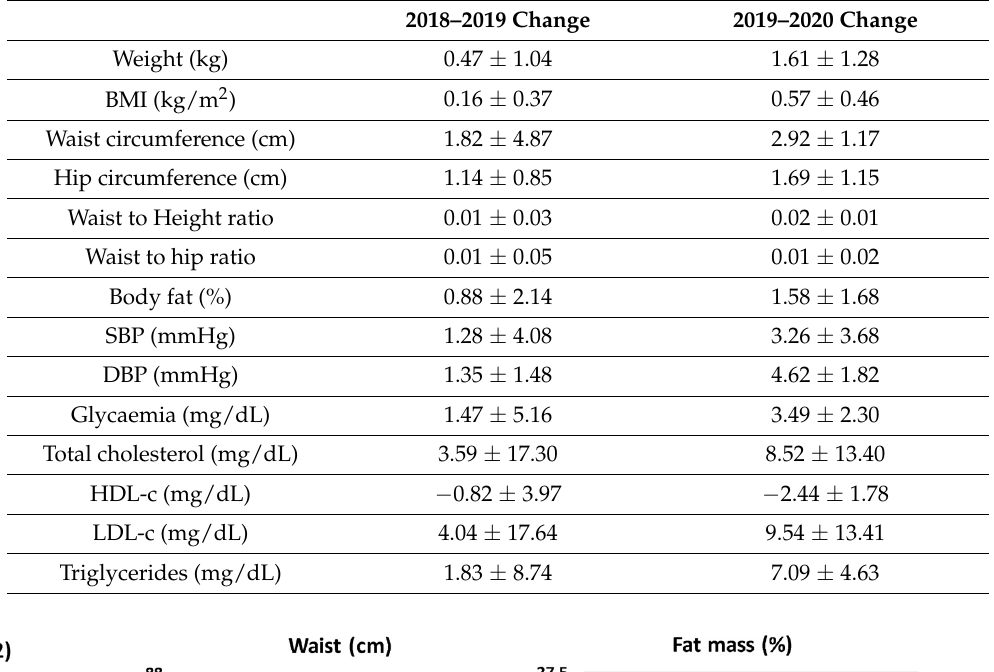
Table 2. Changes in anthropometric, clinical, laboratory, and healthy habit variables in different pre-COVID and COVID years.